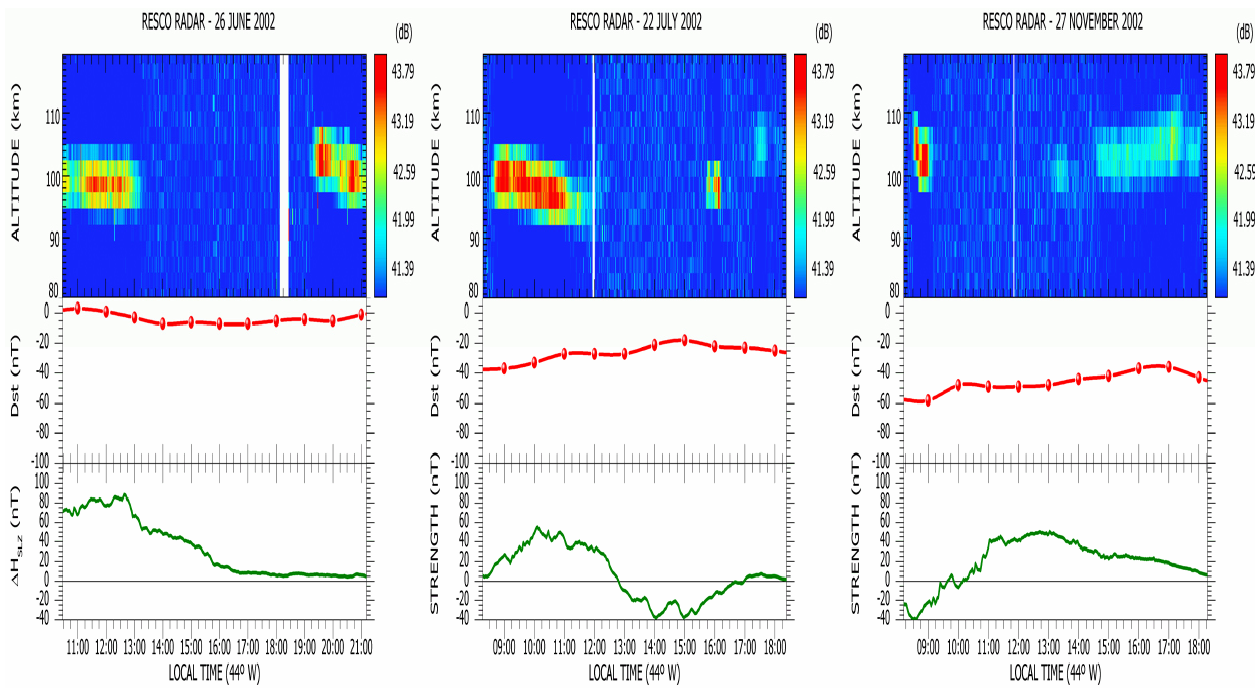
Figure 2. Range Time Intensity (RTI) maps obtained from the RESCO radar on (from the left) 26 June 2002, 22 July 2002 and 27 November 2002, when an evening, an afternoon and a morning CEJ events have been detected, respectively. Corresponding D st index is on the middle panel and the variation of EEJ ground strength ( Δ H = Δ H SLZ - Δ H EUS ) obtained from magnetometers on the bottom panel. Note that on June 26 the EEJ ground strength was replaced by the Δ H SLZ variation.